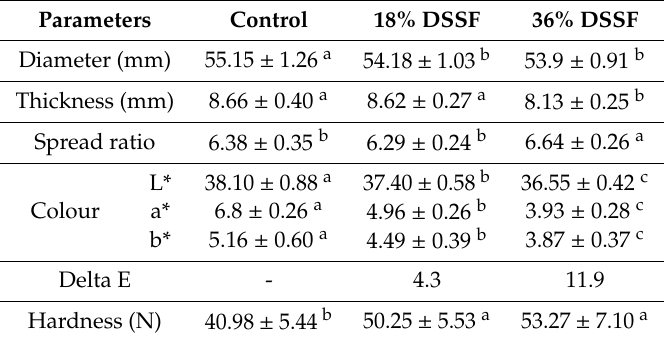
Table 2. Physical properties of control and defatted sunflower seed flour